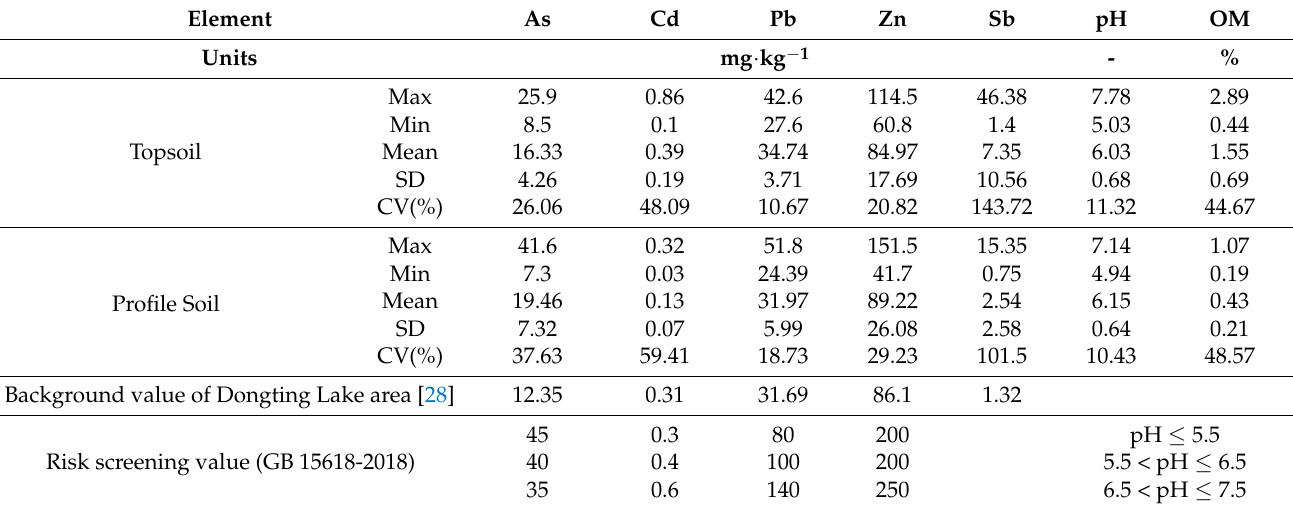
Table 3. Basic physical and chemical properties of heavy metals and metalloids in soils.